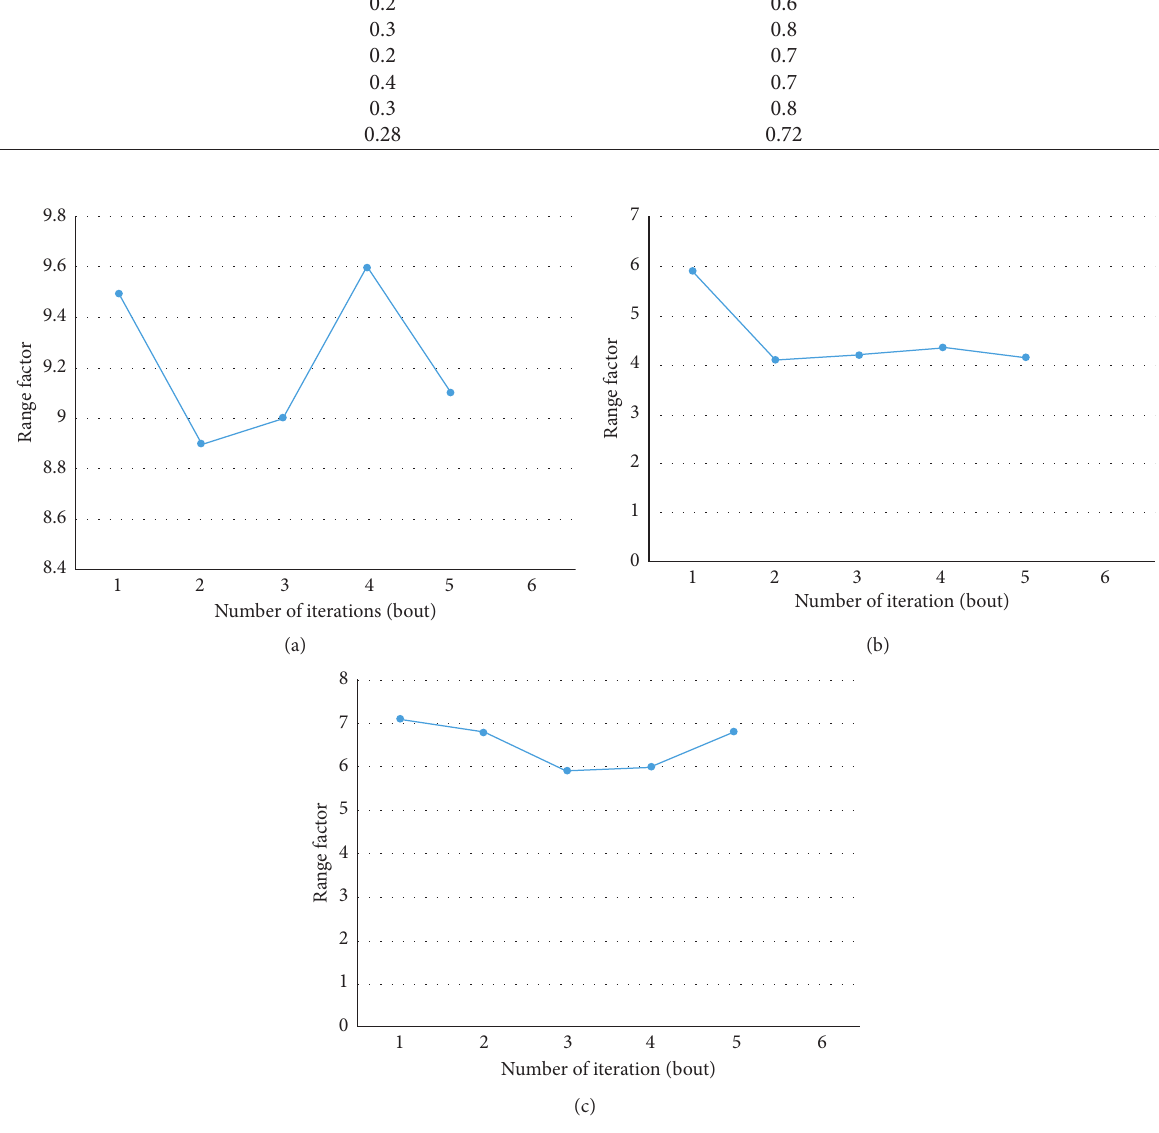
Figure 1: Range coefficient of (a) proposed algorithm, (b) algorithm based on geostationary satellite GOCI sensor, and (c) algorithm based on MODIS